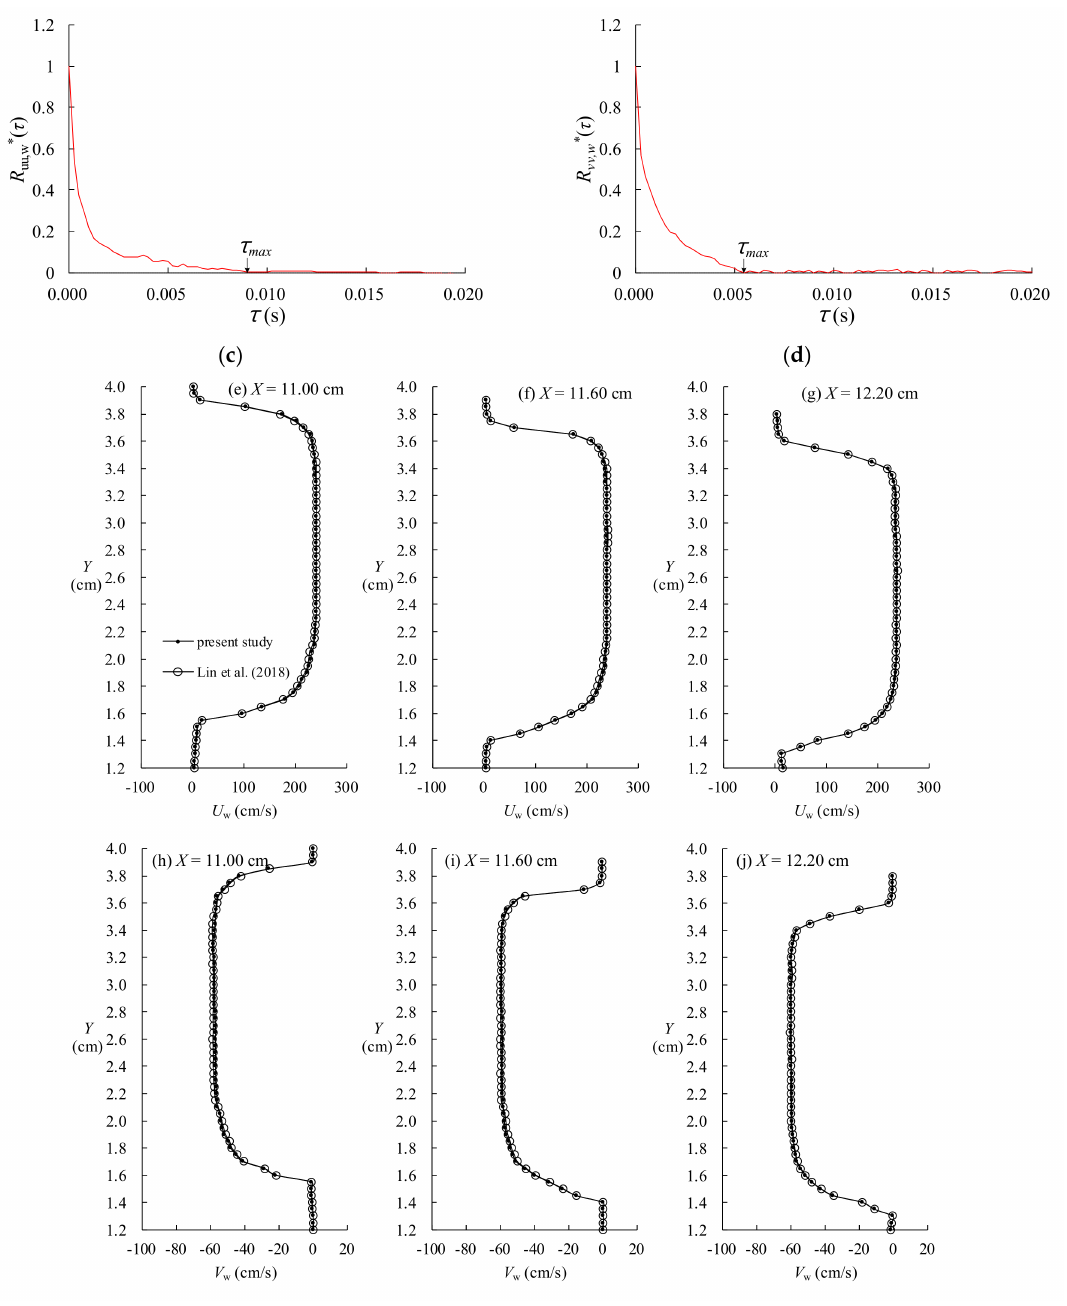
Figure 5. ( a , b ) The time histories of the streamwise/transverse fluctuating velocity u w ( t )/ v w ( t ), obtained at ( X, Y ) = (11.6, 1.63) cm; ( c , d ) The non-dimensional autocorrelation function R uu ,w *( τ ) and R vv ,w *( τ ) for the water stream. The mean streamwise/transverse velocity profile of water stream of the free jet obtained at three different sections: ( e , h ) X = 11.00 cm; ( f , i ) X = 11.60 cm; ( g , j ) X = 12.20